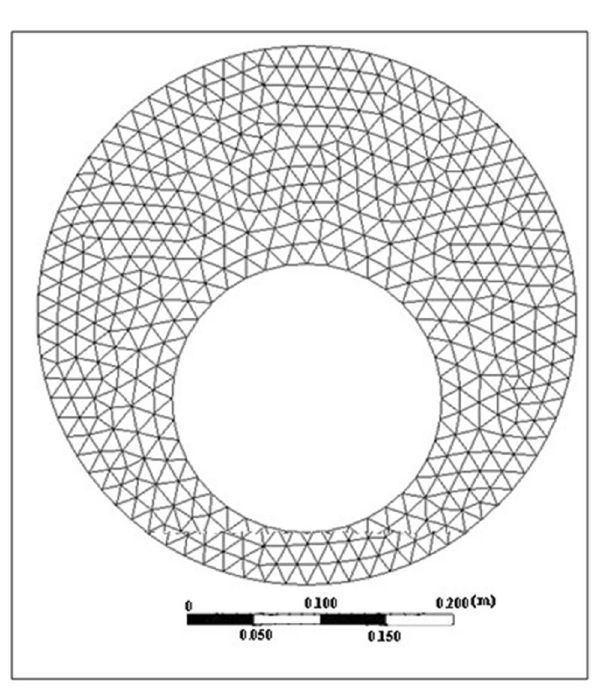
Fig. 7 Transverse cross section of the network created on eccentric annulus-drill string geometry Table 1 Intermediate region characteristics of the simulated well located in Ahwaz oilfield Length (ft) Outer diameter of drill pipe (in.) Well diameter (in.)